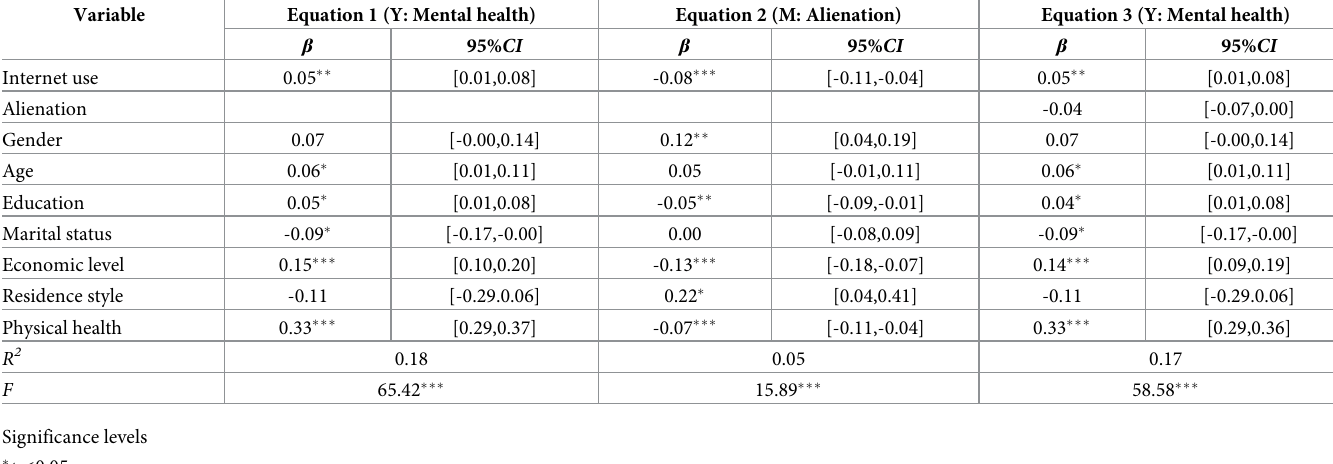
Table 5. Regression results of the relationship among Internet use, alienation and mental health of urban elderly. All variables entered the regression equation after being standardized.